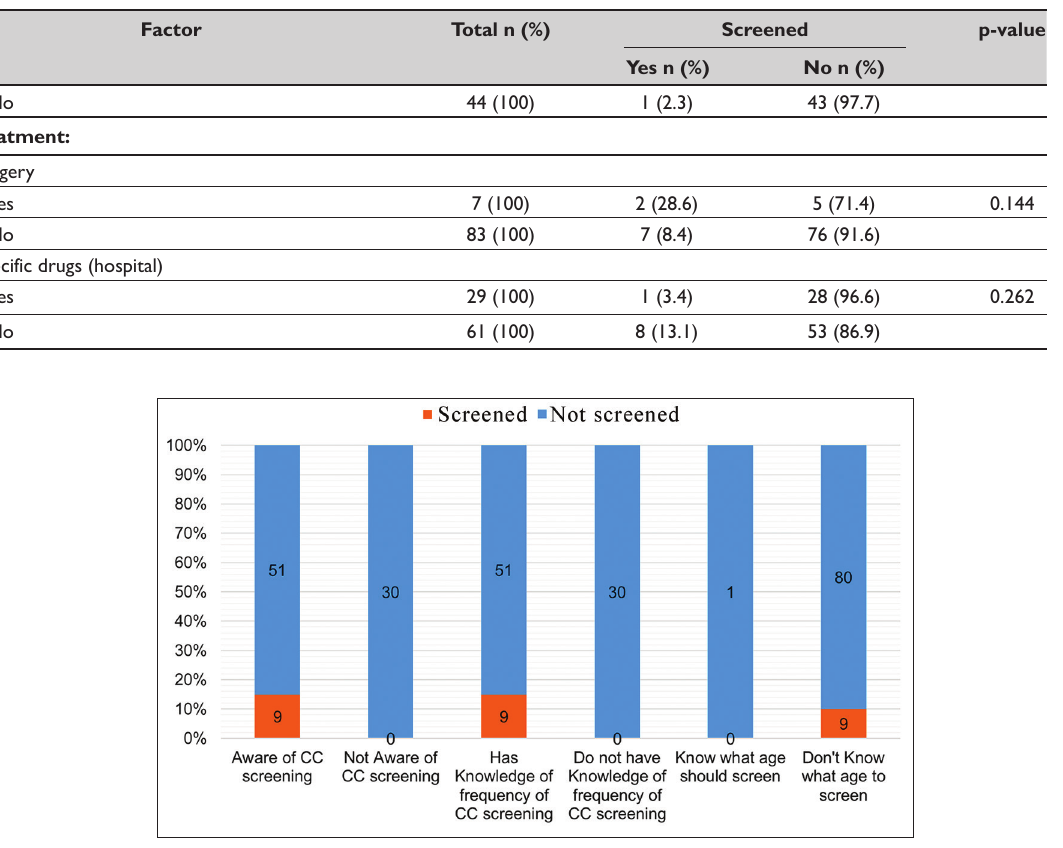
Figure 1 : Knowledge on screening associated with uptake of cervical cancer screening